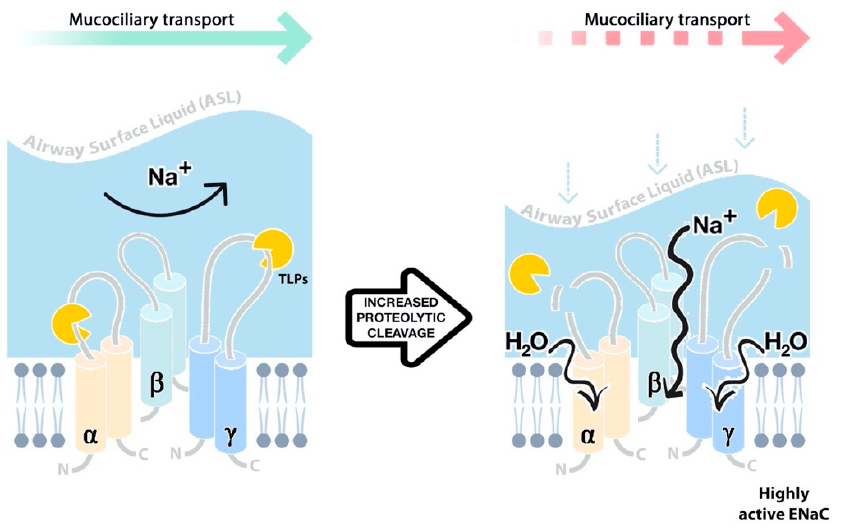
Figure 3. Excessive proteolytic cleavage of ENaC α and γ subunits by trypsin-like proteases (TLPs) and other serine enzymes increases channel activity, leading to the hyperabsorption of Na + , airway surface liquid (ASL) dehydration through increased absorption of water, and impaired mucociliary clearance (MCC).